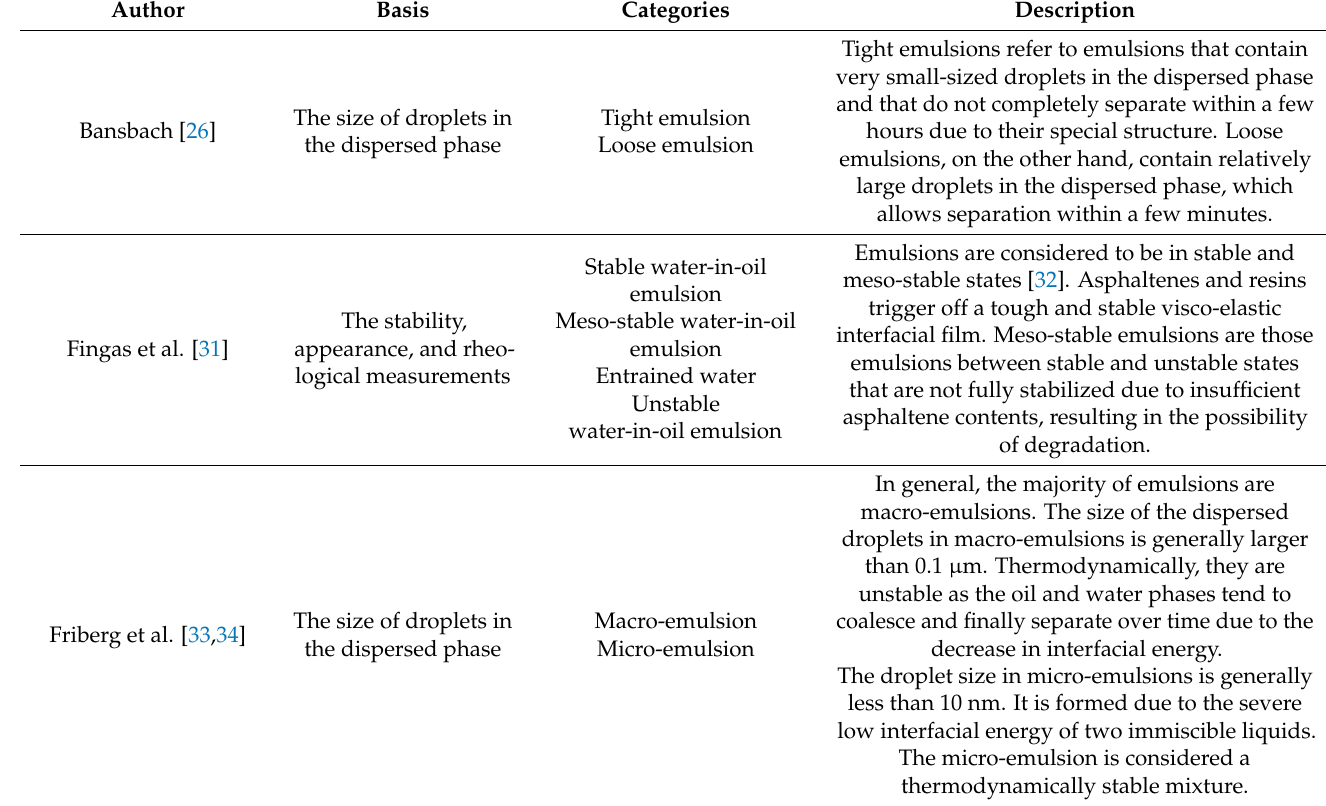
Table 1. Various categories of emulsions from different researchers.